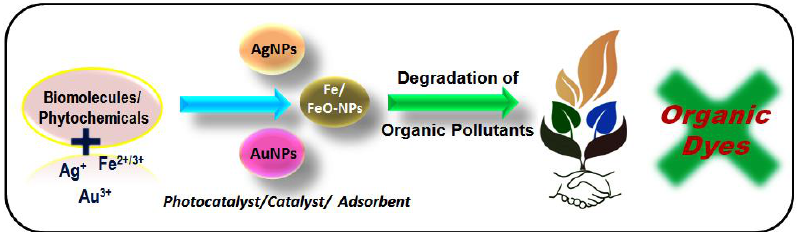
Figure 2. Schematic diagram of the biosynthesis of gold, silver, and iron/iron oxide nanoparticles for the degradation of organic